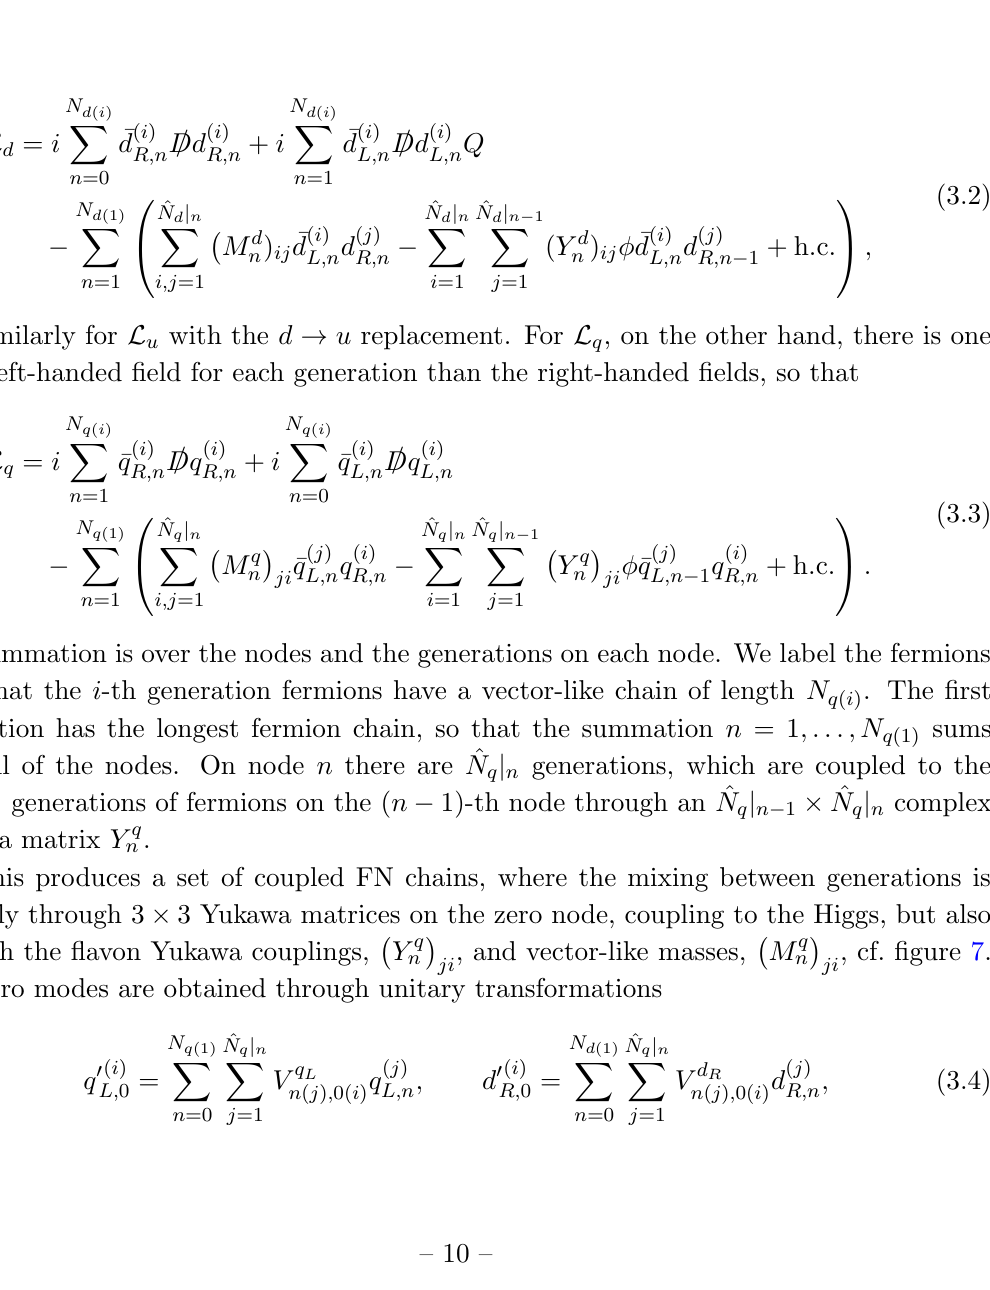
Figure 7 . The vector-like chains (blue) for the inverted FN model with G FN = U(1) FN . The chiral fermions are on the zero node, denoted by the red ellipse, which also contains the Higgs. Di(cid:11)erent generations on each node mix through vector-like masses ((cid:12)lled orange ellipses), as do the (cid:12)elds on neighboring nodes through Yukawa (cid:13)avon interactions (empty orange